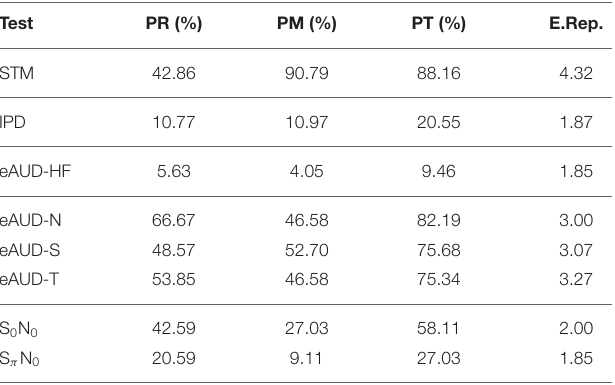
TABLE 3 | Table with the probability of needing repetitions (PR), and the probability of having missing values